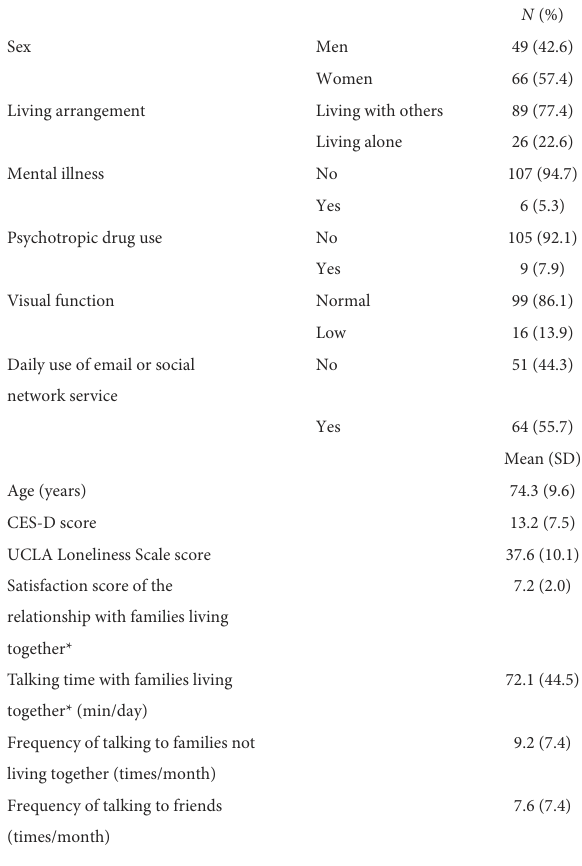
TABLE 1 Characteristics of participants at